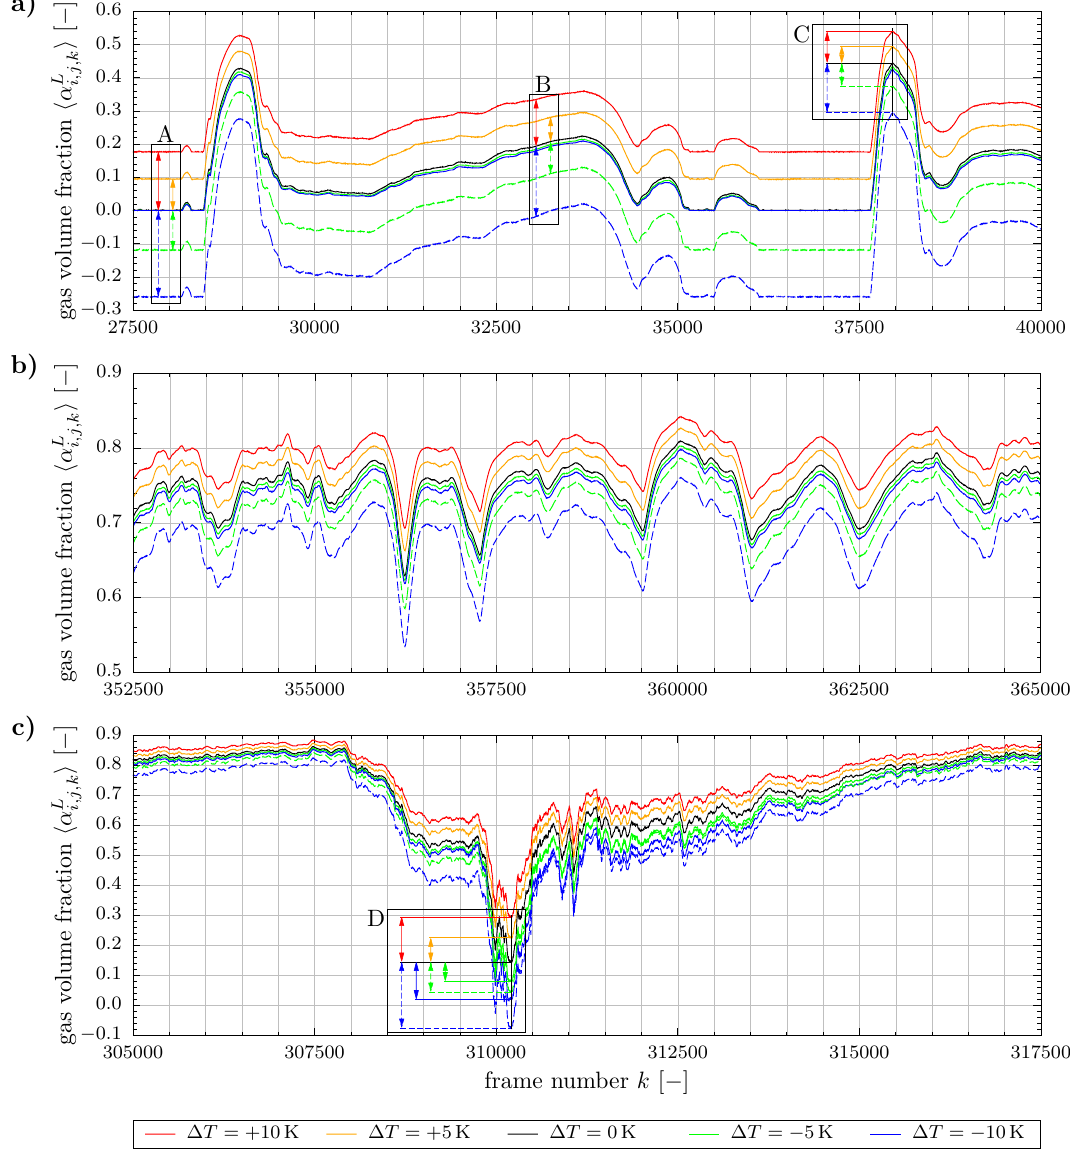
Figure 7. Influence of varying reference temperature on phase fraction data: ( a ) Plug flow pattern (run no. 50 in ref. [14] with T = 24.8 ◦ C , v l , s = 0.63ms − 1 , v g , s = 0.22ms − 1 ), ( b ) Stratified wavy flow pattern (run no. 102 in ref. [14] with T = 26.4 ◦ C, v l , s = 0.10ms − 1 , v g , s = 4.80ms − 1 ), ( c ) Slug flow pattern (run no. 106 in ref. [14], T = 25.1 ◦ C, v l , s = 0.65ms − 1 , v g , s = 4.79ms − 1 ). Solid and dashed lines denote with and without application of the cutting algorithm, respectively. Details A to D are described in the